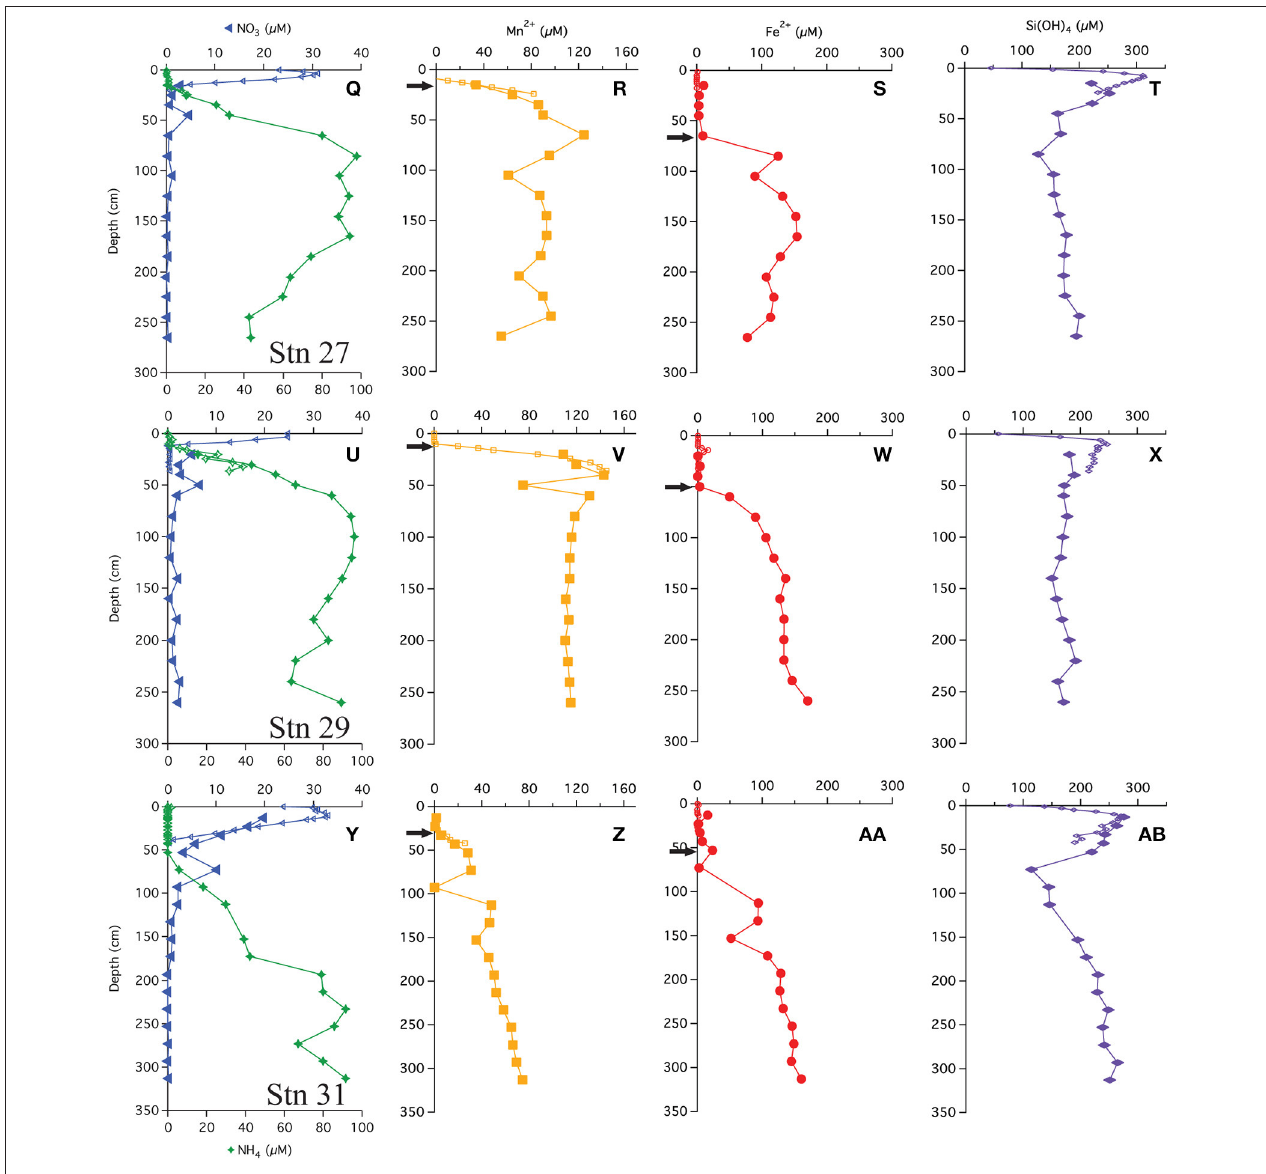
FIGURE 2 | Pore water profiles of NO − 3 , NH + 4 , Mn + 2 , Fe + 2 , and Si(OH) 4 . Arrows indicate depths where the flux was calculated following Fick’s first law. (A-D) Profiles from station 3, (E-H) Profiles from station 9, (I-L) Profiles from station 13, (M-P) Profiles from station 25, (Q-T) Profiles from station 27, (U-X) Profiles from station 29, (Y-AB) Profiles from station